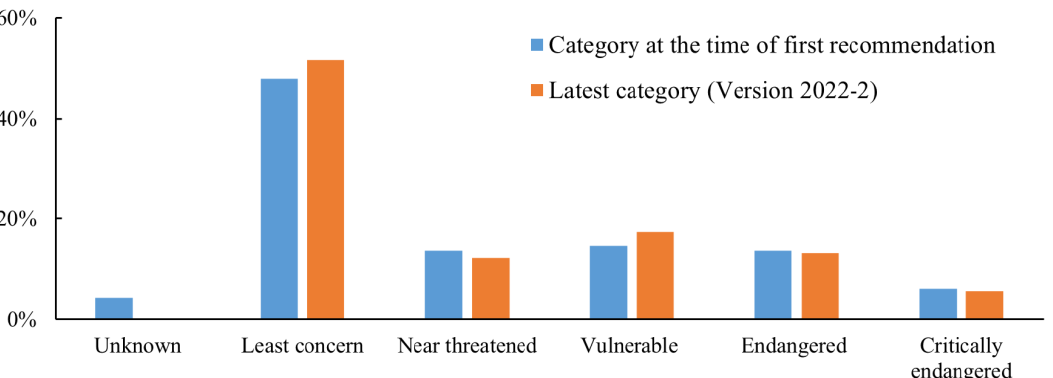
Figure 4. Proportions of the 213 recommended umbrella species across different threatened categories assessed at the year closest to the first recommendation of each umbrella species (blue bars), and assessed in the latest version of the IUCN Red List of threatened species (2022-2; orange bars). Any categories assigned as unknown, not recognized, and data deficient were grouped as unknown.